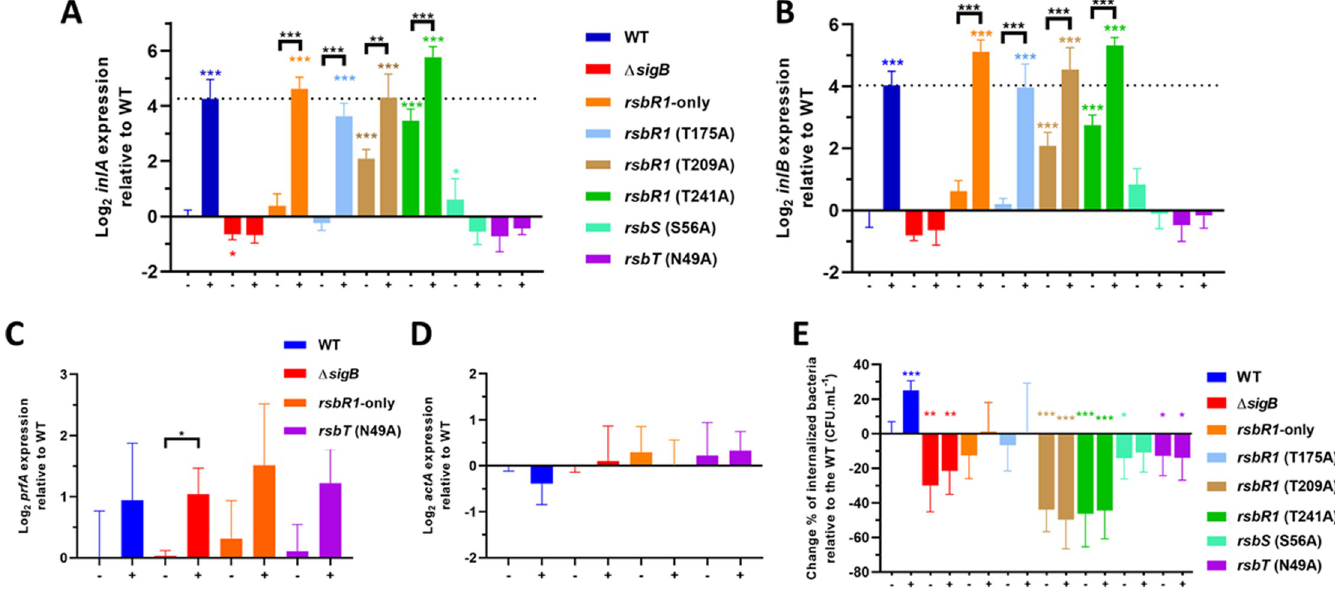
Fig 8. Acid sensing via the stressosome triggers upregulation of the inlAB invasion operon and influences Caco-2 cell invasion without affecting PrfA activity. (A) inlA , (B) inlB , (C) prfA and (D) actA expression was obtained from mid-log phase cultures of strains used in this study. Cultures were untreated (-) and treated (+) in pH 5.0 for 15 min at 37˚C. (E) Caco-2 invasion experiments performed on untreated (-) and treated (+) cultures in pH 5.0 for 15 min. L . monocytogenes wild type and mutant strains were in contact with the Caco-2 epithelial cells for 1 h and extracellular bacteria were eliminated with extensive washing and the supplementation of 50 μ g.mL -1 of gentamicin to fresh tissue culture medium. Quantification of internalized L . monocytogenes was obtained from lysed Caco-2 cells 1 h after the gentamicin treatment. The untreated wild type strain was arbitrary converted to 0% and all samples were normalized to percentage of CFU.mL -1 relative to the untreated wild type. Statistical analysis was performed using a paired Student’s t -test relative to the wild type untreated after 15 min ( � , P value of < 0.05; �� , P value of < 0.01; ��� , P value of <